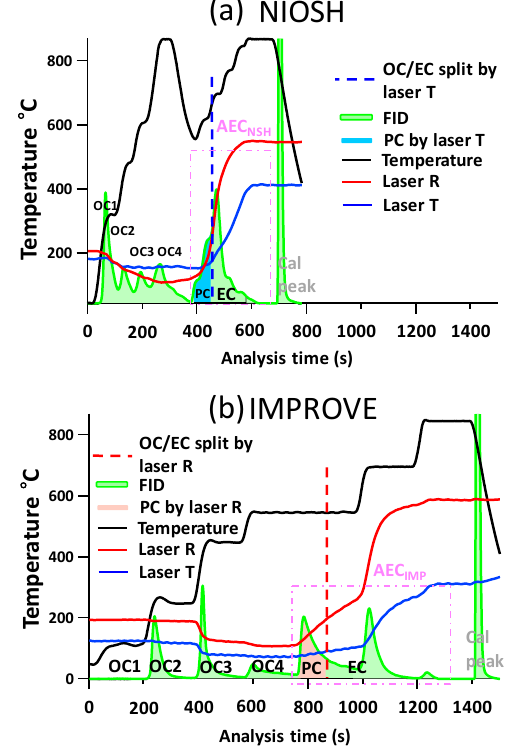
Figure 1. Thermograph of typical thermal optical analysis (sample CW20130118) using a Sunset carbon analyzer. (a) NIOSH proto-